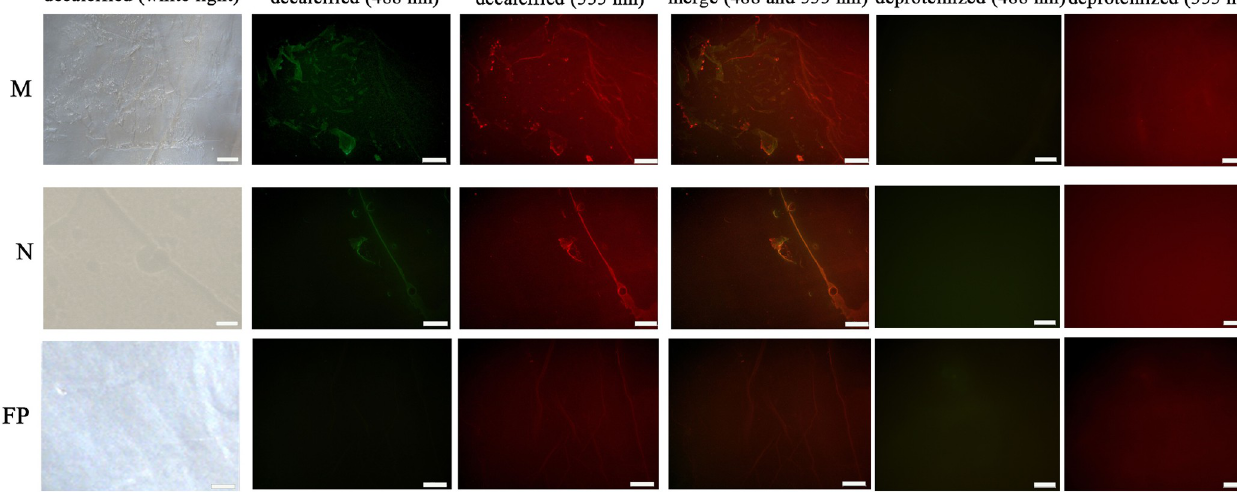
S1 Fig. Alignment of WLP cDNA with the deduced amino acid sequence (GenBank QGA67049.1). The termination codon was denoted by an � .